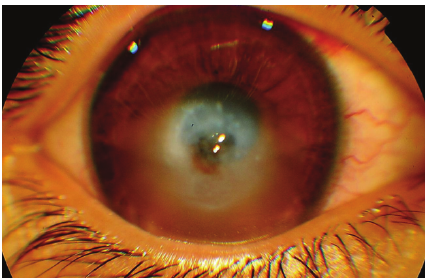
Figure 1: Slit lamp exam of the right eye showing a central Descemet’s membrane rupture with inferocentral corneal edema